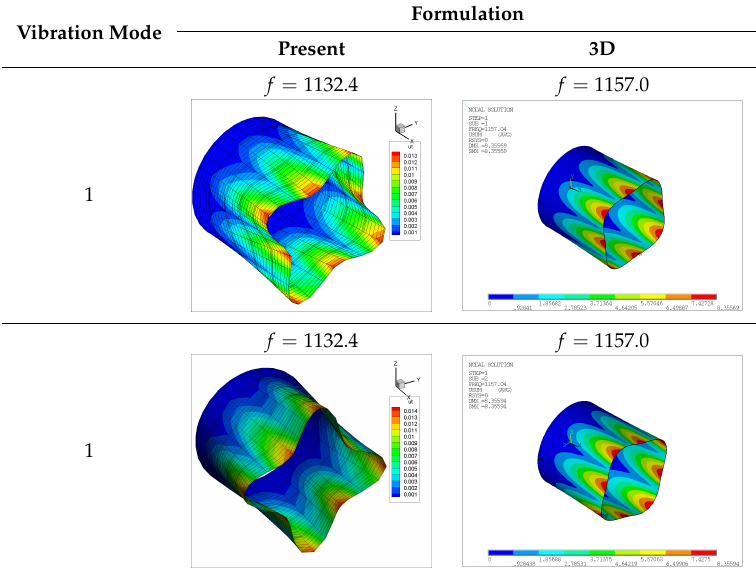
Table 16. Vibration modes of a cylinder with linear thickness variation and CF boundary